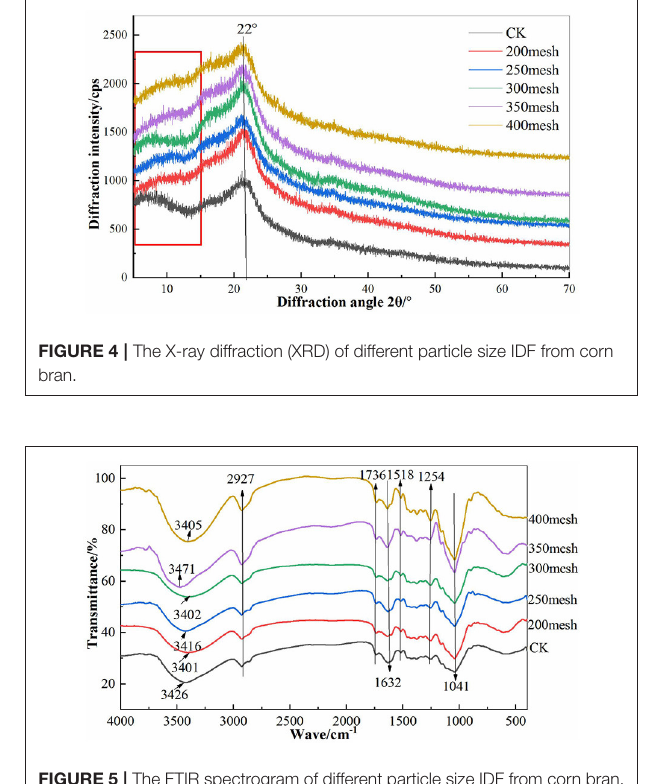
FIGURE 5 | The FTIR spectrogram of different particle size IDF from corn